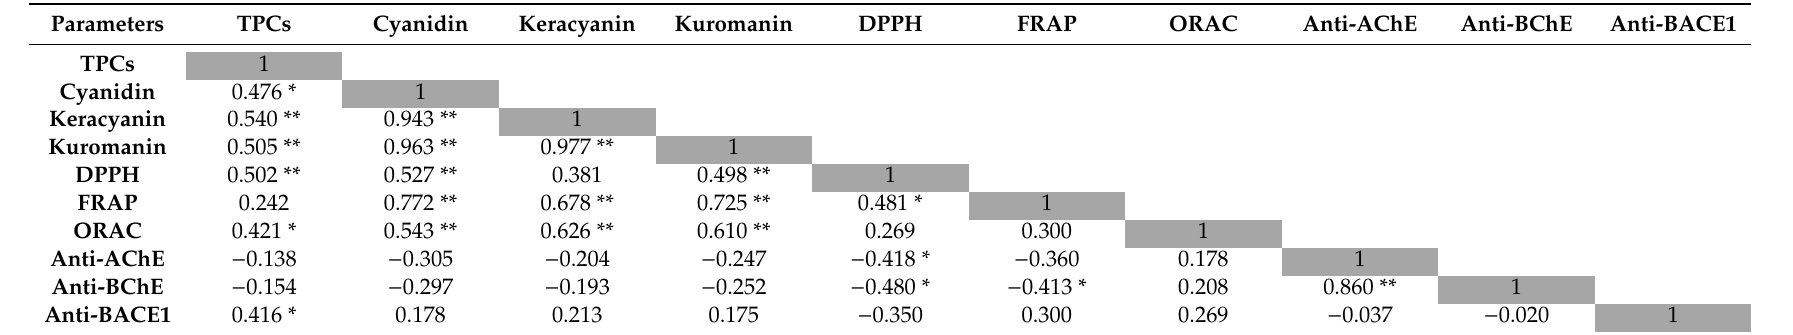
Table 4. Correlation coe ffi cient ( r ) of total phenolic contents (TPCs), cyanidin contents, keracyanin contents, kuromanin contents, antioxidant activities as being determined by 2,2-diphenyl-1-picrylhydrazyl (DPPH) radical scavenging, ferric ion reducing antioxidant power (FRAP), and oxygen radical absorbance capacity (ORAC) assays and anti-Alzheimer activities through inhibition of the key enzymes (acetylcholinesterase (AChE), butyrylcholinesterase (BChE), and beta-secretase 1 (BACE-1)) of aqueous extracts of Morus fruit